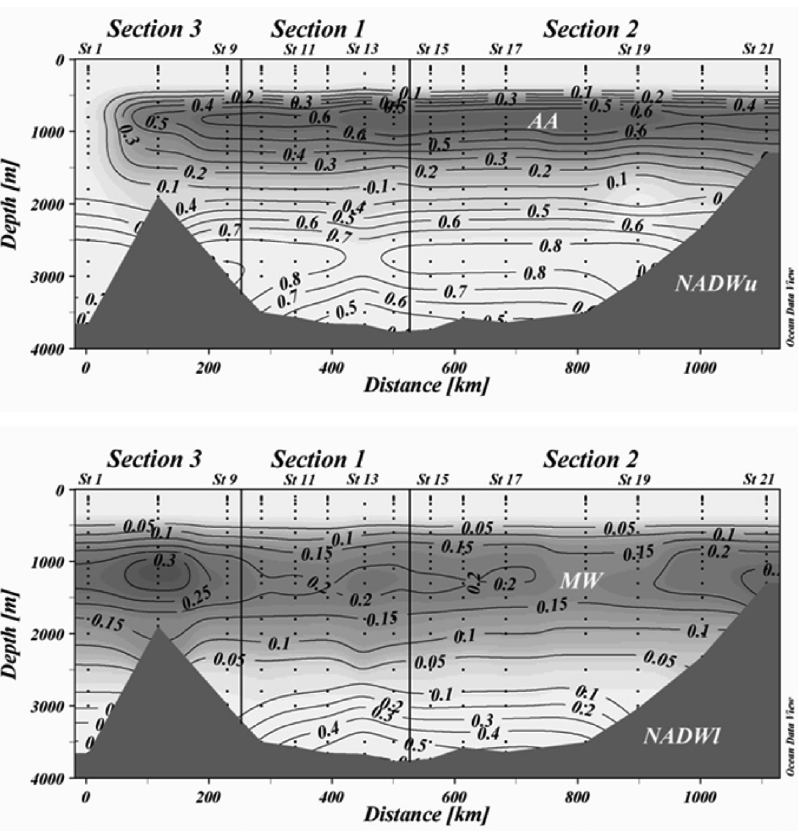
Fig . 7. – Water mass contribution from the ESTOC station to station 21 following the cruise track. Upper panel: Diluted Antarctic Water (AA) and upper North Atlantic Deep Water (uNADW). Lower panel: Mediterranean Water (MW) and lower North Atlantic Deep Water